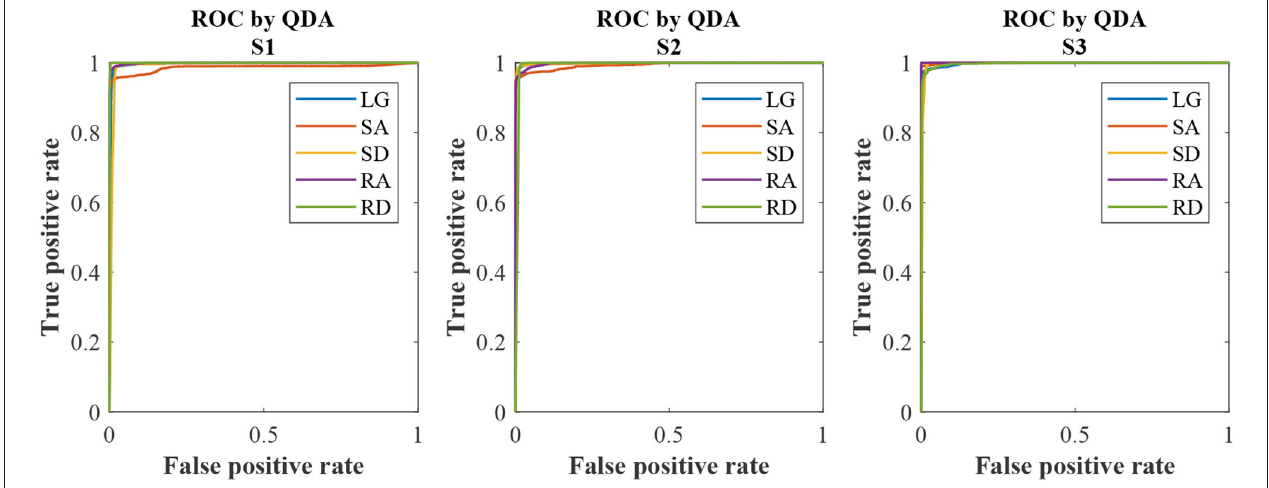
FIGURE 8 | ROC curves for the subjects (S1, S2, and S3) based on QDA. The color of solid line denotes locomotion mode as the legend shows.